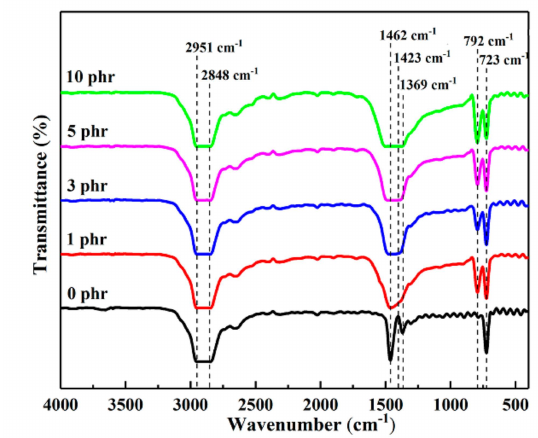
Figure 2. Fourier transform infrared spectra of LDPE and h-BN / LDPE composite materials.